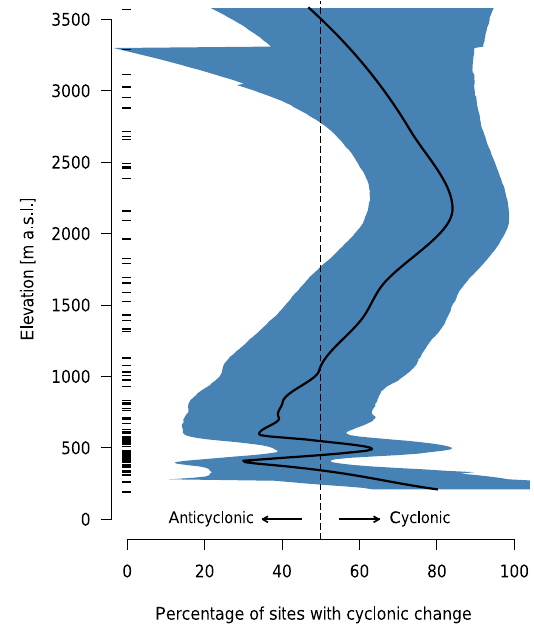
Figure 9. Elevation dependence of cyclonic and anticyclonic influ- ences during penumbral shading. Using MeteoSwiss sites the per- centage of sites showing cyclonic or anticyclonic effects was deter- mined and elevational best estimates (bold line) and uncertainty of the estimate (90% confidence interval in blue) were estimated us- ing nonparametric bootstrapping. The vertical dashed line at 50% indicates the insignificant random outcome. Each horizontal mark near the elevation axis represents one weather